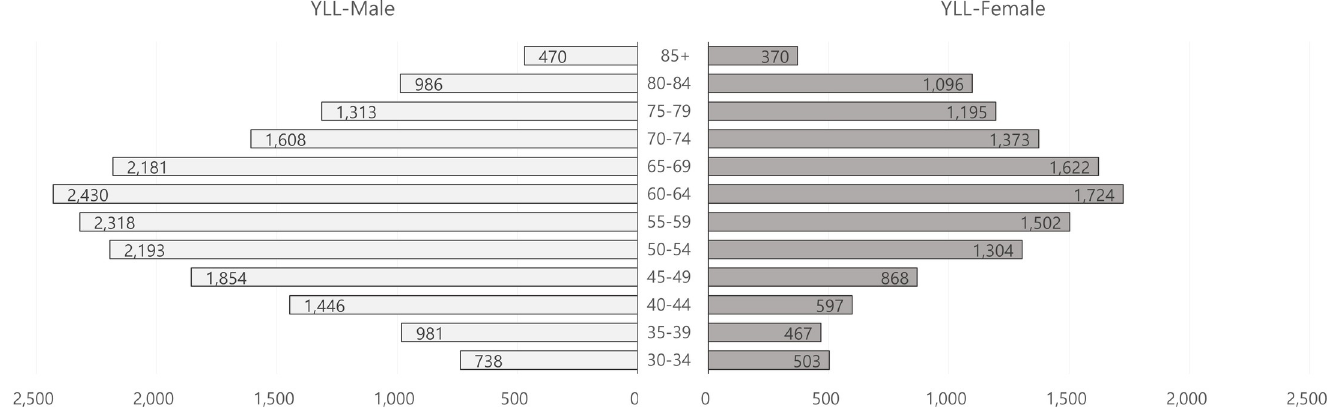
Fig 3. Estimated YLLs per 100,000 population by gender and age group. YLLs, years of life lost. Unit: YLLs per 100,000 population.